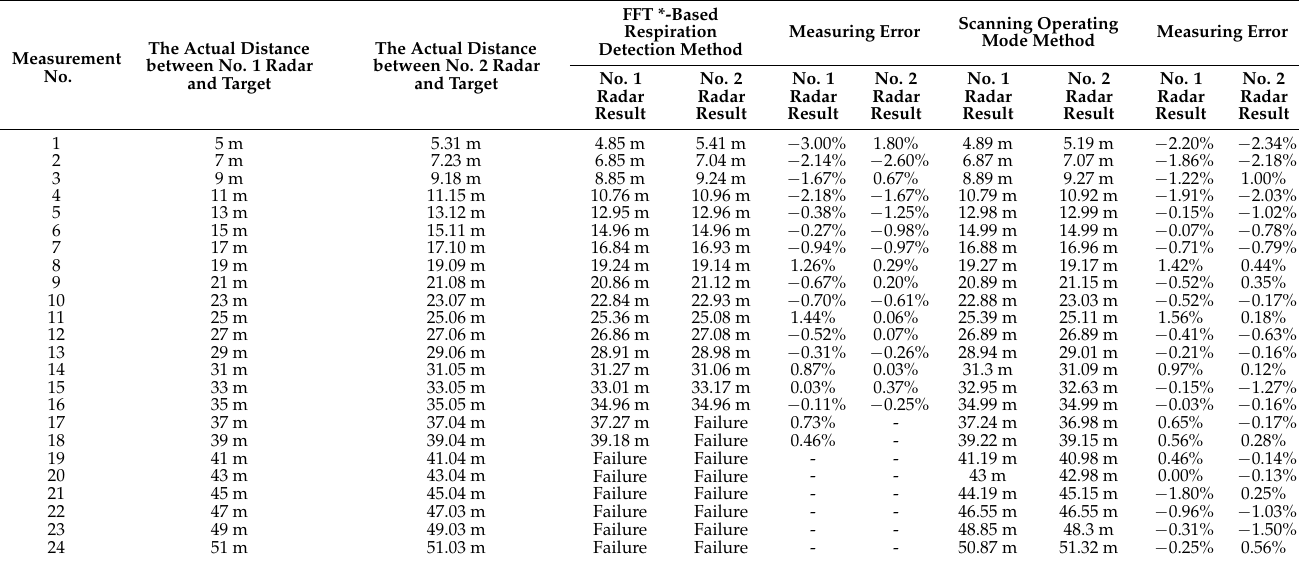
Table 3. The measurement results of the type-I experiment.